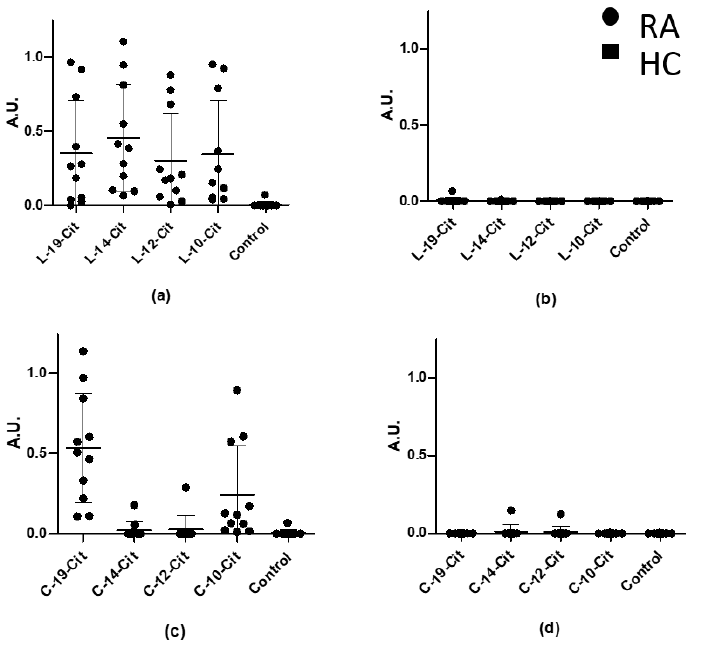
Figure 2. Reactivity of rheumatoid arthritis (RA) sera and healthy control (HC) sera samples to truncated linear and cyclic citrullinated α -enolase peptides analysed in ELISA. Peptides are plotted from left to right with decreasing length. An Arg-containing peptide was used as control (KIHARCEIFDSRGNPTVEC). ( a ) Reactivity of RA sera to linear peptides. ( b ) Reactivity of HC sera to linear peptides. ( c ) Reactivity of RA sera to cyclic peptides. ( d ) Reactivity of HC sera to cyclic peptides. A.U. were defined as absorbances normalized relative to a positive RA control pool.